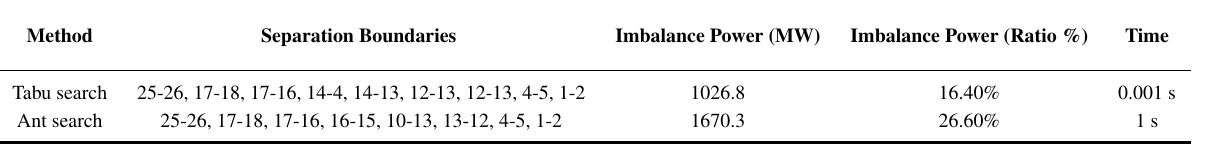
Figure 17. The pictorial result of instance ieee118-3-b generated by the algorithm with L = 15 . Table 4. Performance comparison between the ant search algorithm and our tabu search algorithm on the IEEE 39-bus